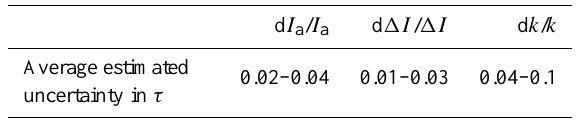
Table 3. Estimated values of uncertainty in retrieved τ due to I a , 1I (the difference between I sat and I 0 sat ) , and k . d I a / I